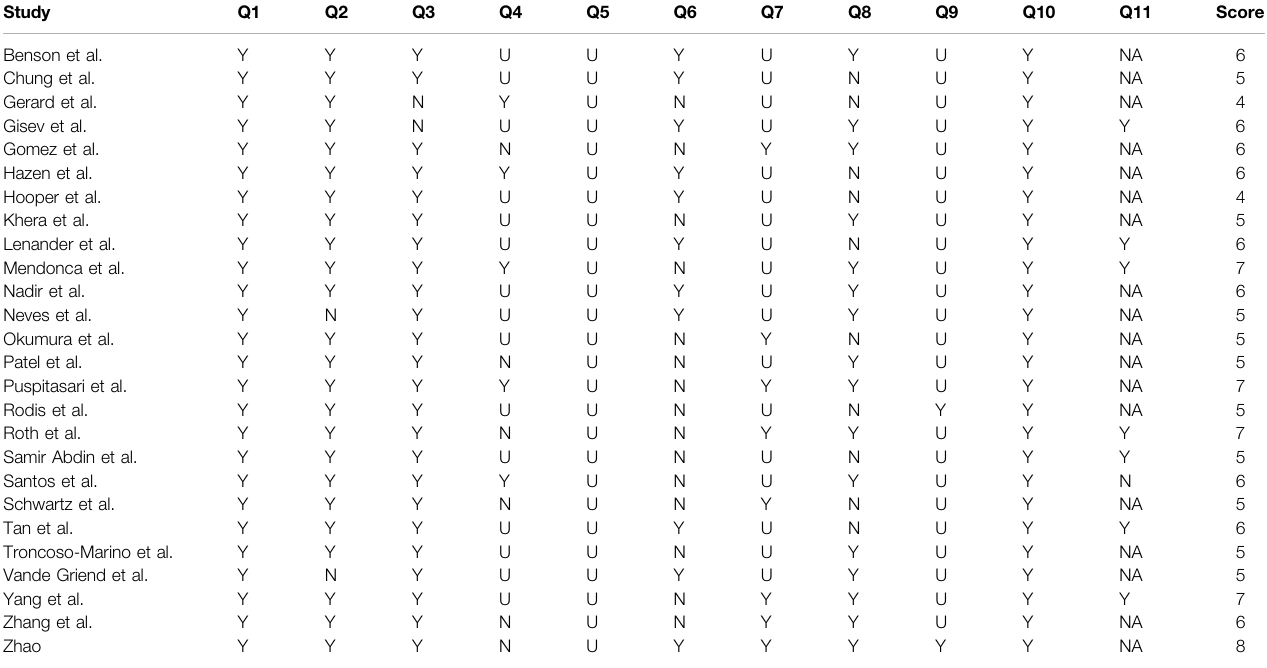
TABLE 1 | Quality assessment of included